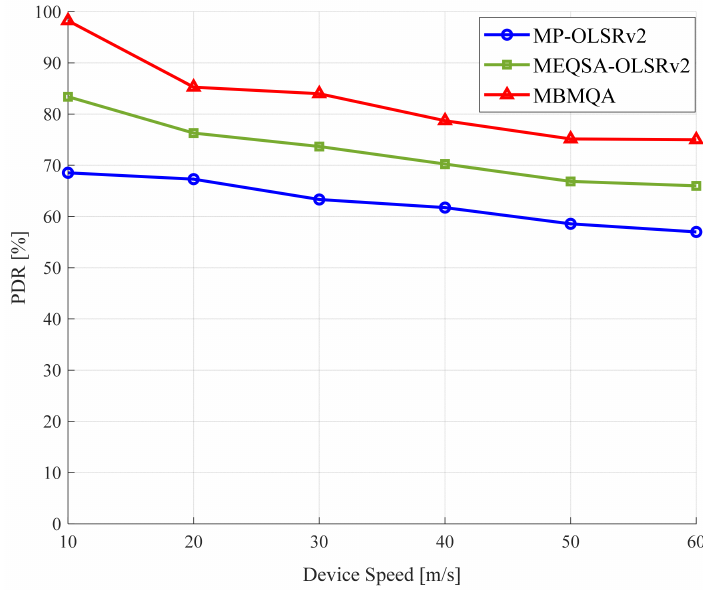
Figure 6. Packet delivery ratio for various device speeds.